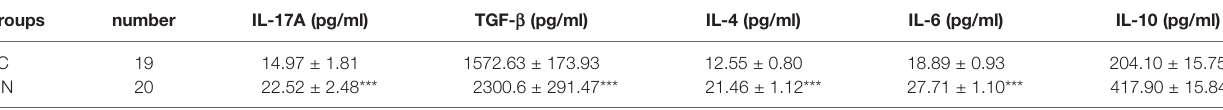
TABLE 3 | Levels of IL-17A, IL-4, IL-6, IL-10 and TGF- b in patients ’ plasma.